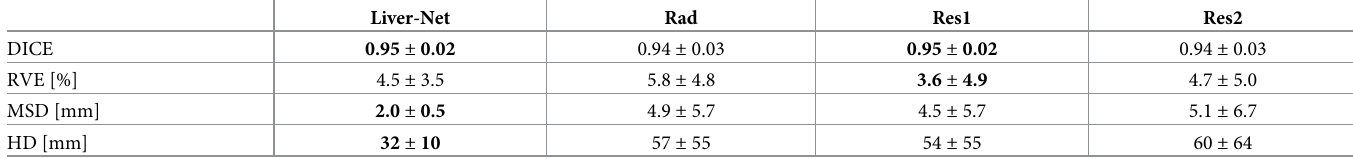
Table 1. Evaluation results (mean ± standard deviation) for the Liver-Net and manual routine segmentations by a radiologist (Rad) and two residents (Res1, Res2) when compared to the reference.